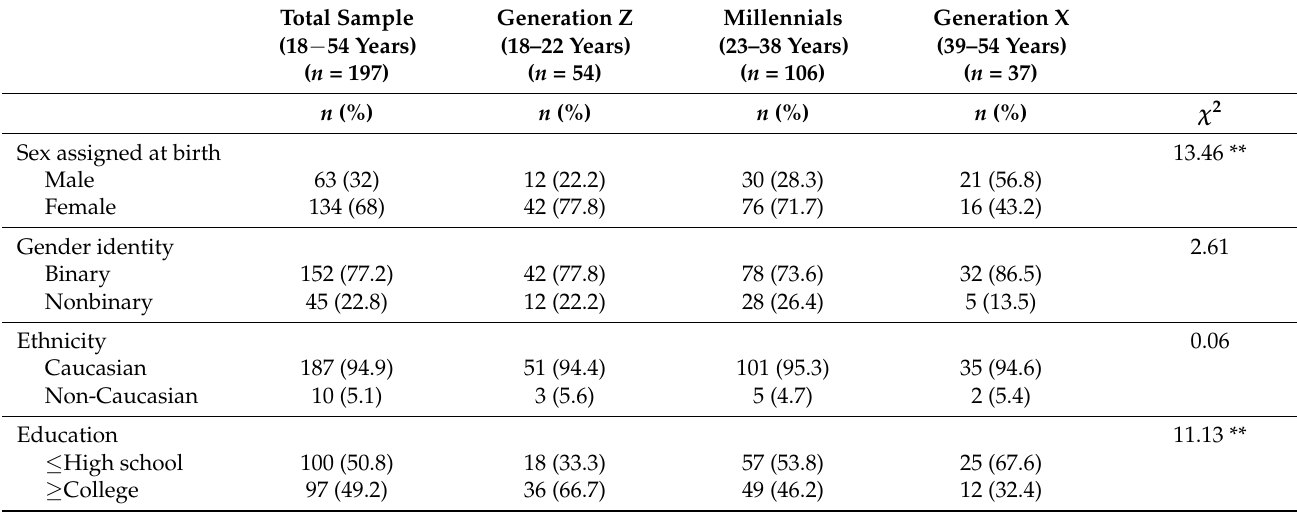
Table 1. Demographics of the